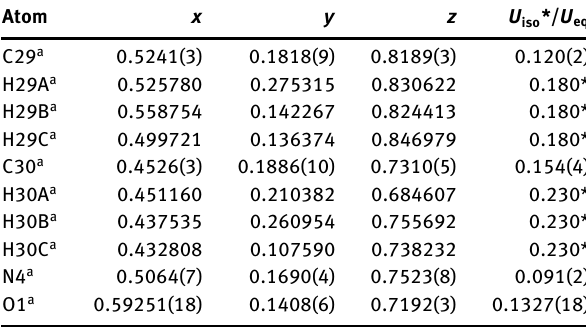
Table 2: Fractional atomic coordinates and isotropic or equivalent isotropic displacement parameters (Å 2